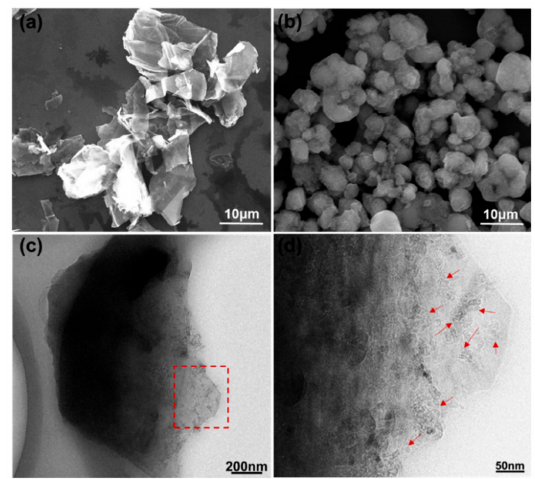
Figure 2. ( a ) SEM image of FG, ( b – d ) SEM and TEM images of aphanitic graphite (AG). The red arrows in Figure 2d point the small graphite nanocrystals.